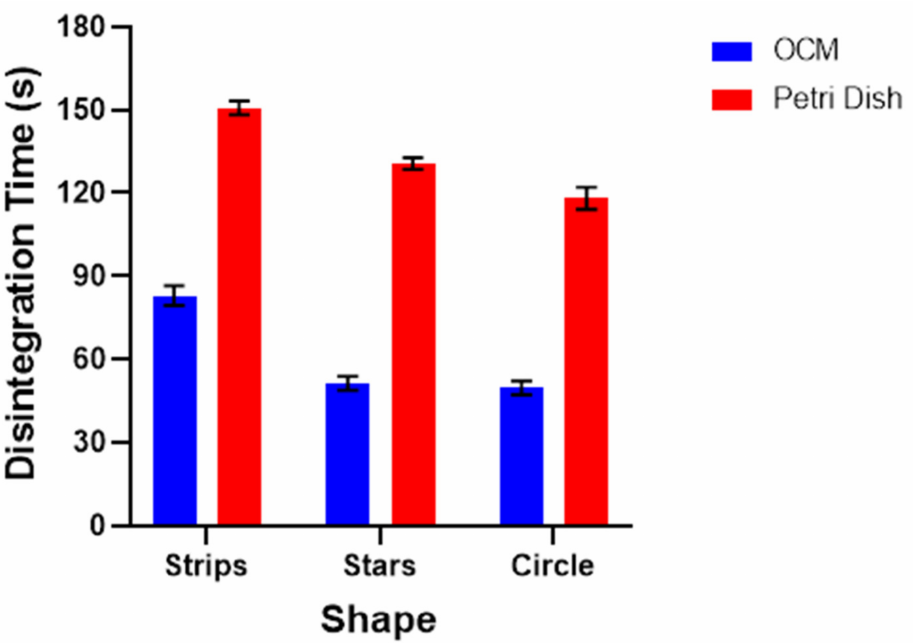
Figure 6. Disintegration time of films, as performed by both the OCM and modified petri